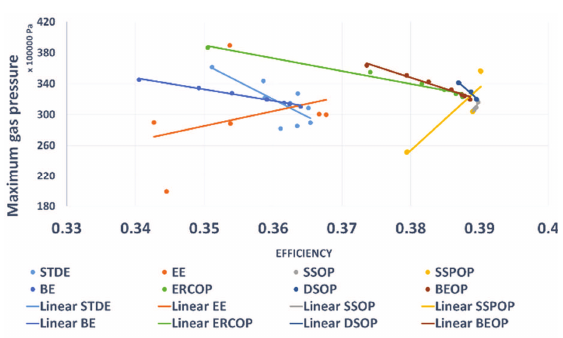
Fig. 19. Maximum gas pressures for all